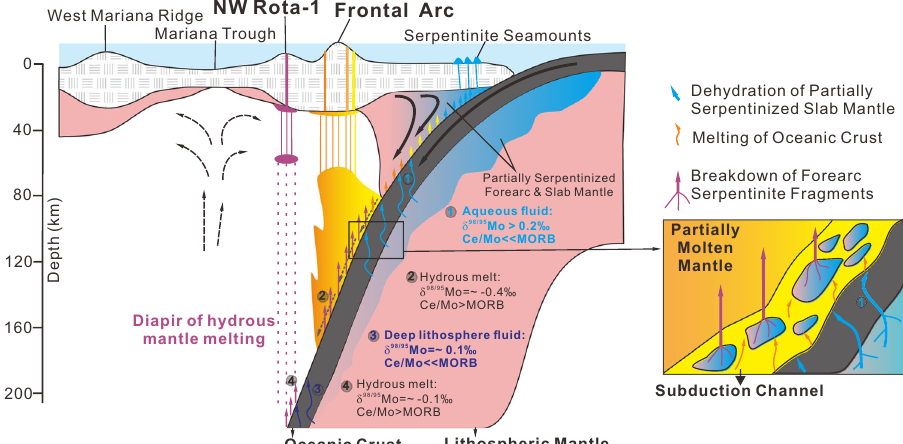
Fig. 7 Schematic cross-section through the Mariana arc, showing slab dehydration/melting processes. Shallow (<80 km) slab dehydration results in partial serpentinization of the forearc mantle. The partially serpentinized forearc mantle is then dragged down by the subducting slab and is further fl uxed by fl uid/melt from the slab at depth >80 km. Dehydration and melting of the slab were triggered by the breakdown of serpentinite in the subducted lithospheric mantle. Breakdown of multiple episodes of fl uid/melt fl uxed serpentinite in the subduction channel at >80 km depth released its re- homogenized fl uid/melt to the overlying mantle wedge and stimulated partial melting. Serpentinite being dragged down from the mantle wedge gradually decomposed in the subduction channel and is likely became totally exhausted by 200 km depth, then a breakdown of serpentinite in the slab lithosphere control the generation of slab melt at depth >200